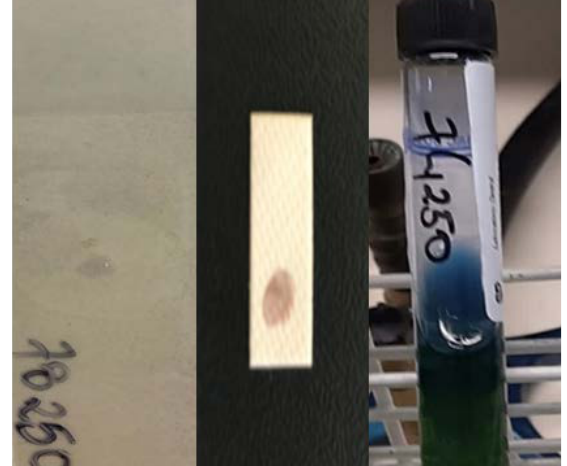
fIgURE 4,5,6 – Biochemical Tests of Catalase, Oxidase and Citrate